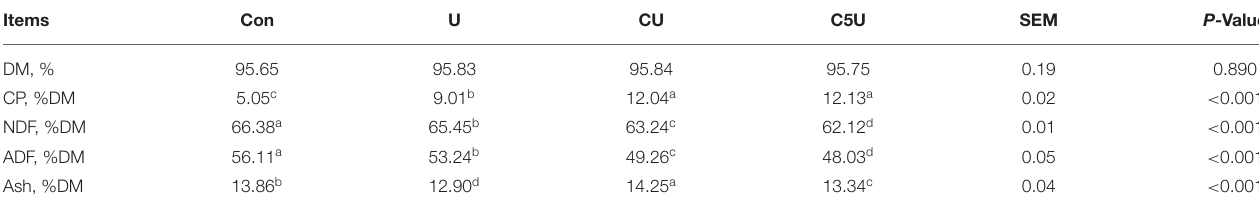
TABLE 1 | Effect of corn steep liquor (CSL) and urea pre-treatment on the chemical composition of anaerobically stored rice straw (RS). Items Con U